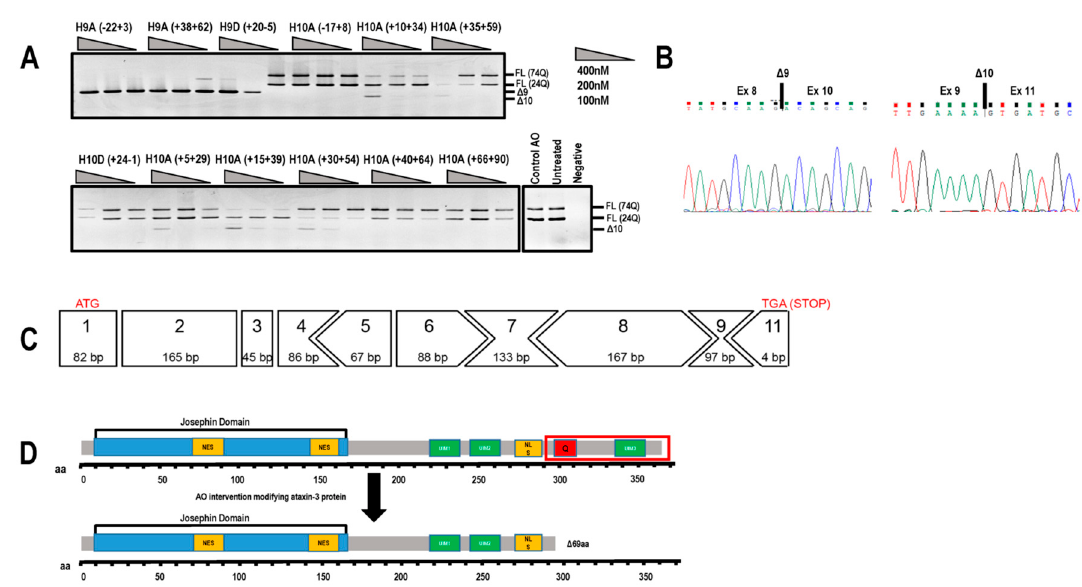
Figure 2. Evaluation of antisense oligonucleotides (AOs) designed to alter ATXN3 transcript structure. ( A ) Screening of 2 ′ -Me phosphorothioate (PS) AOs targeting exon 9 or exon 10 for removal. AOs were transfected as lipoplexes at three concentrations, 400, 200, 100 nM, and after RT-PCR and gel fractionation, products representing the full-length (FL 74Q; FL 24Q), exon 9-skipped ( Δ 9, 384 bp) and exon 10-skipped ( Δ 10, 362bp) transcripts were identified. ( B ) Sanger sequencing of the RT-PCR products generated by skipping of exon 9 or 10, shows the junction between exon 8 and 10, and exons 9 and 11, respectively. ( C ) Although removal of exon 10 alters the reading frame, the residue encoded by the exon 9 and 11 junction codon is synonymous (lysine). Immediately following this lysine is an in-frame termination codon (TGA). ( D ) Removal of exon 10 from the ATXN3 coding sequence results in a truncated, 291 aa protein (missing the terminal 69 aa) of approximately 34 kDa that is reported to be functional. aa = amino acid; NES = nuclear export signal; NLS = nuclear localisation signal; UIM = ubiquitin interacting motif. Q = polyglutamine tract.